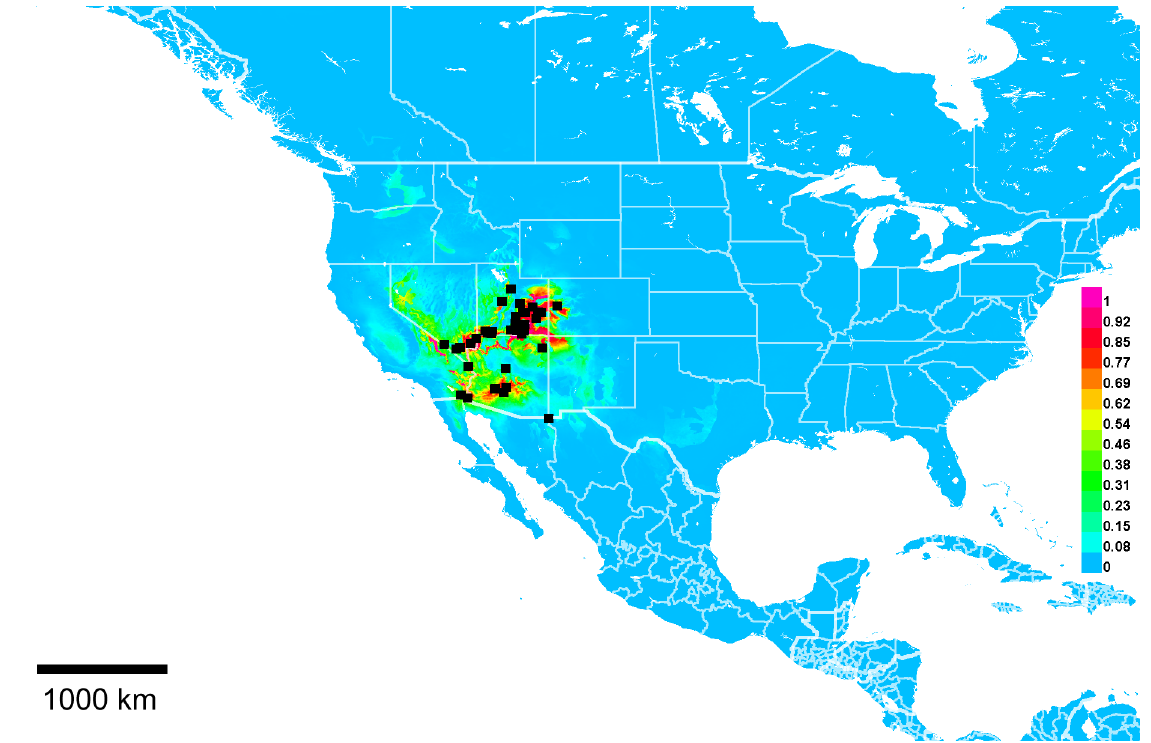
Fig. 17. Georeferenced collection records of Lasioglossum ( D .) diabolicum sp. nov. (black squares) and predicted distribution by maximum entropy ecological niche modelling in Maxent (colour shading). Warmer colours indicate higher cloglog probability of